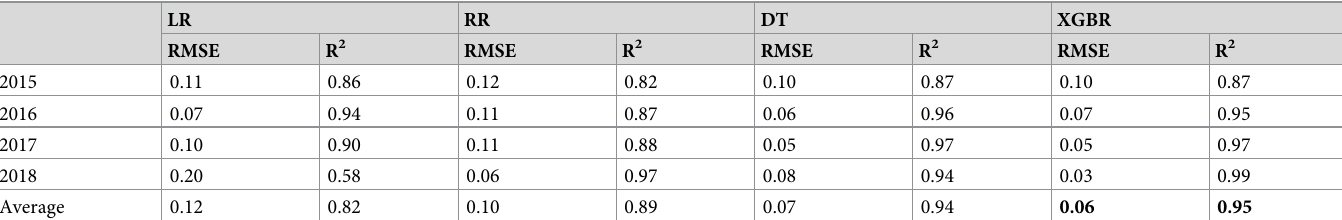
Table 3. Performance for the four different applied models in regional analysis: Linear Regression (LR), Ridge Regression (RR), Decision Tree Regressor (DT), Extreme Gradient Boosting Regressor (XGBR). The last row shows the metric’s average value for the four years. LR RR DT XGBR RMSE R 2